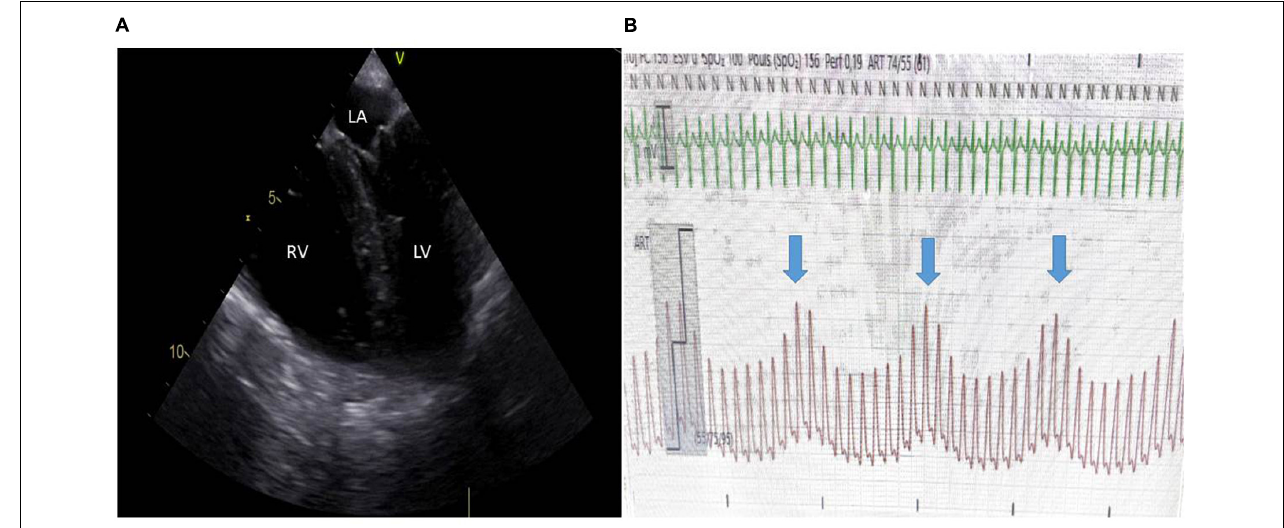
FIGURE 1 | Acute cor pulmonale in a patient ventilated for ARDS and in shock and completely adapted to the respirator. (A) A mid-esophageal 4-chamber view demonstrated severe RV dilatation with paradoxical septal motion. (B) Invasive low blood pressure with significant pulse pressure variation (blue arrows indicate insufflation) through a radial catheter. Central venous pressure was also elevated. LV, left ventricle; LA, left atrium; RV, right